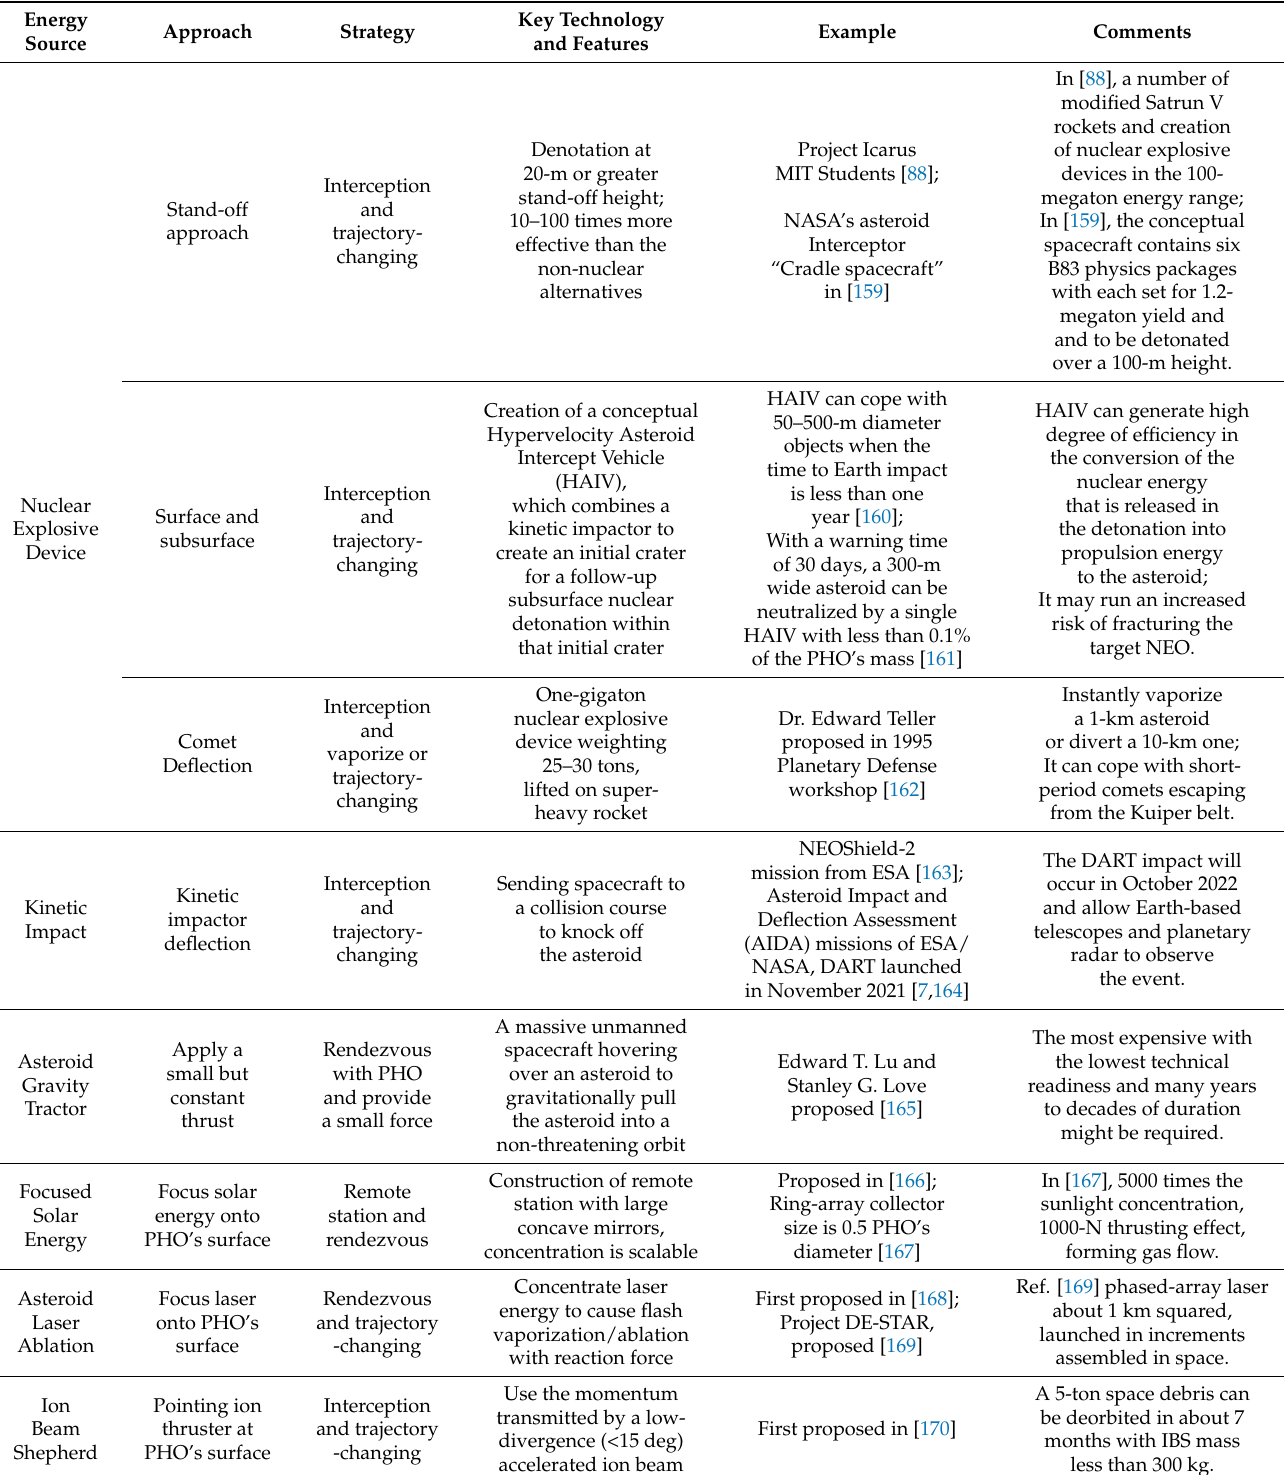
Table 2. A summary of representative mitigation